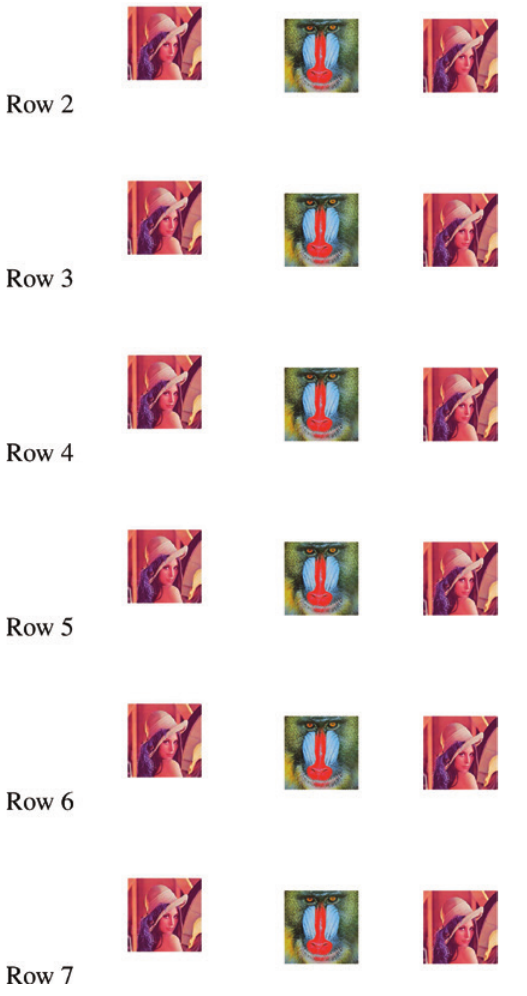
Table 7: Images after Decompression by Parallel and Nonparallel